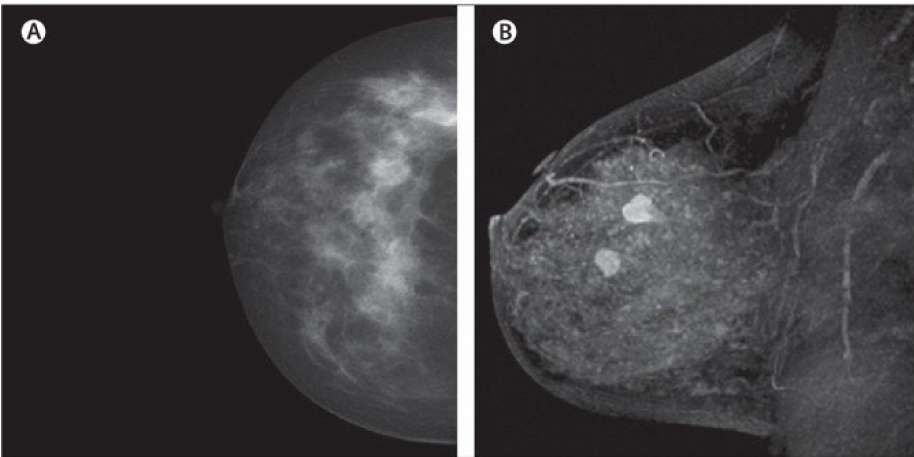
Figure 4. Dense cancerous breast tissue images conducted by MRI method from different angles. ( A ) Normal; ( B ) malignant [82]. Reprinted/adapted with permission from [82]. 2011,